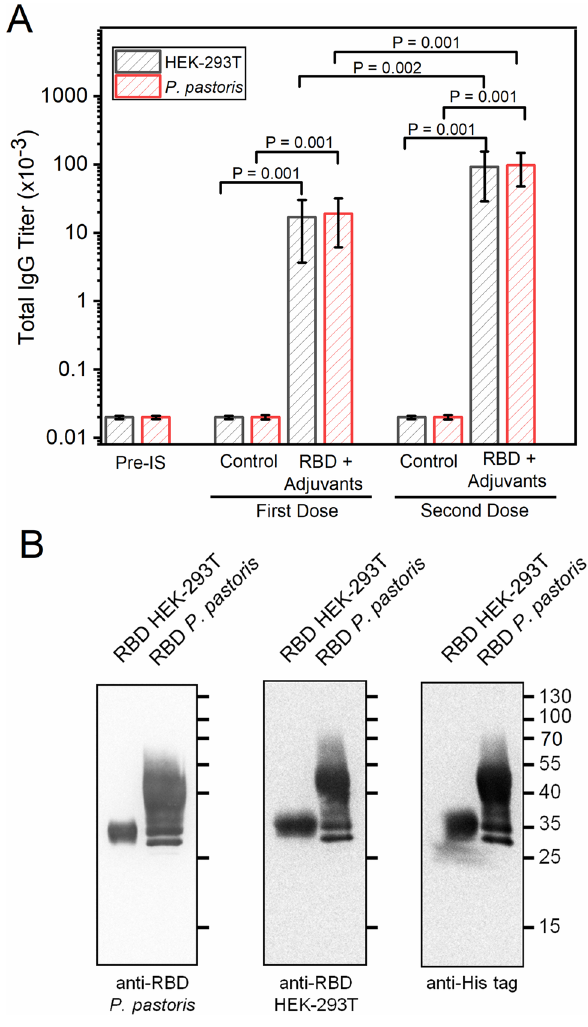
Figure 9. Evaluation of the cross-reactivity of antibodies produced in mice immunized with P. pastoris RBD . ( A ) Titers of antibodies obtained by immunization with RBD from P. pastoris plus adjuvants. Each bar represents the group mean (n = 5) for specific titers as determined by end-point-dilution ELISA. ELISA was performed with plates coated with RBD protein produced in HEK-293T cells (black sparse bars) or P. pastoris (red sparse bars). First dose corresponds to blood samples obtained 30 days post-first immunization, and second dose to samples obtained 20 days post-second immunization. Pre IS, Pre Immune Sera; RBD + Adjuvants, RBD produced in P. pastoris + Al(OH) 3 + CpG-ODN 1826; Control, Al(OH) 3 + CpG-ODN 1826. P values indicate significant differences between different groups. Bars indicate SD. P values (t-test) are shown for statistically significant differences (p < 0.05). ( B ) Purified RBD produced in HEK-293T (1.0 μg) and in P. pastoris (3.0 μg) were analyzed by Western blot using sera from mice immunized with RBD produced in HEK-293T (anti-RBD HEK-293T, left), or in P. pastoris (anti-RBD, P. pastoris center). As a control a primary antibody against the His tag present in both RBD recombinant proteins was used